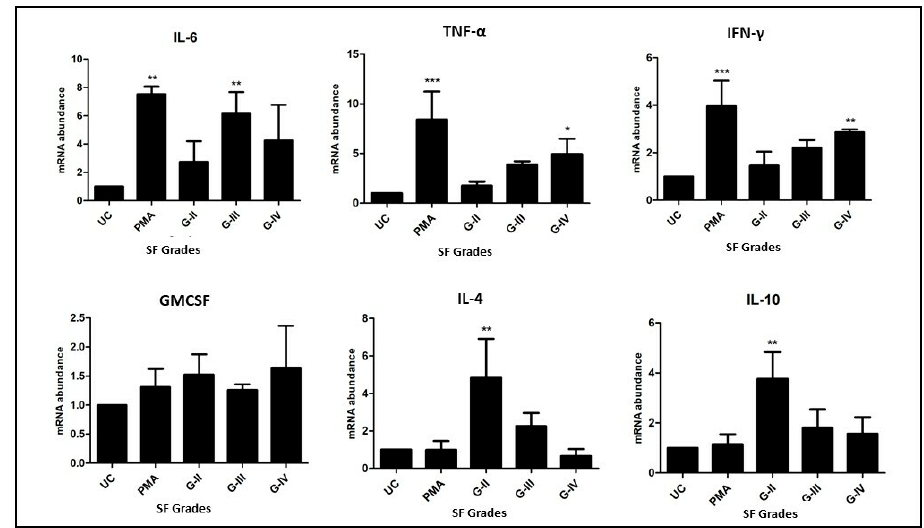
Figure 3. Functional status of the newly differentiated cells from in vitro U937 cells was investigated in terms of mRNA abundance of the cytokine gene produced by the new cells. The expression amount of each cytokine gene was normalized against ACTB, a house-keeping gene; in the cytokine panel, IL-6, TNF- α , IFN- γ , and GMCSF are M1-macrophage-specific, and IL-4 and IL-10 are M2-specific cytokines; * p < 0.05, ** p < 0.01, *** p < 0.001, as compared to UC.